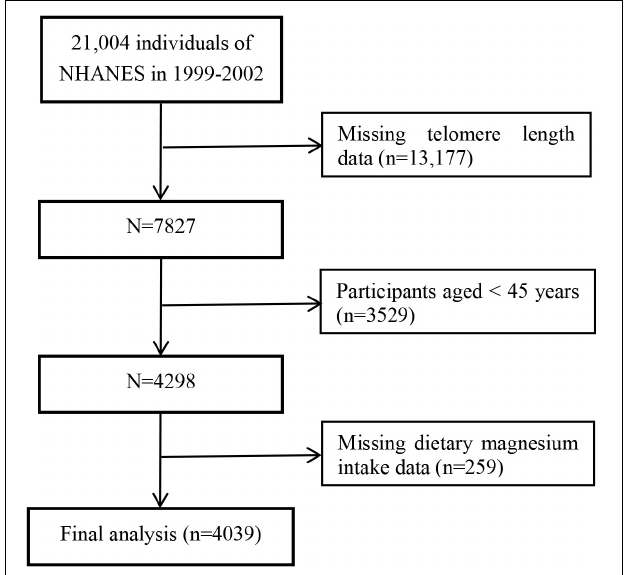
FIGURE 1 | Flow chart of the study participants.